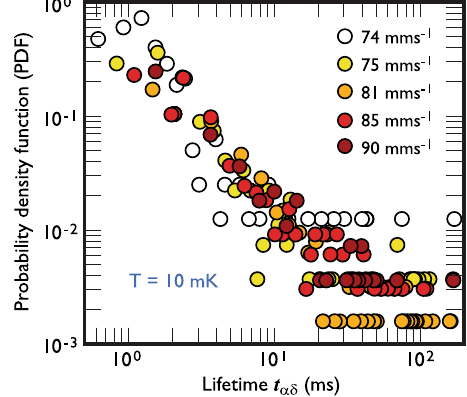
Fig. 4 The release process. A probability density function (PDF) of captured vortex lifetimes t αδ at selected fork velocities. The discrete data at long lifetimes are the result of single observed events. The data point colours re fl ect the same data as in Fig.